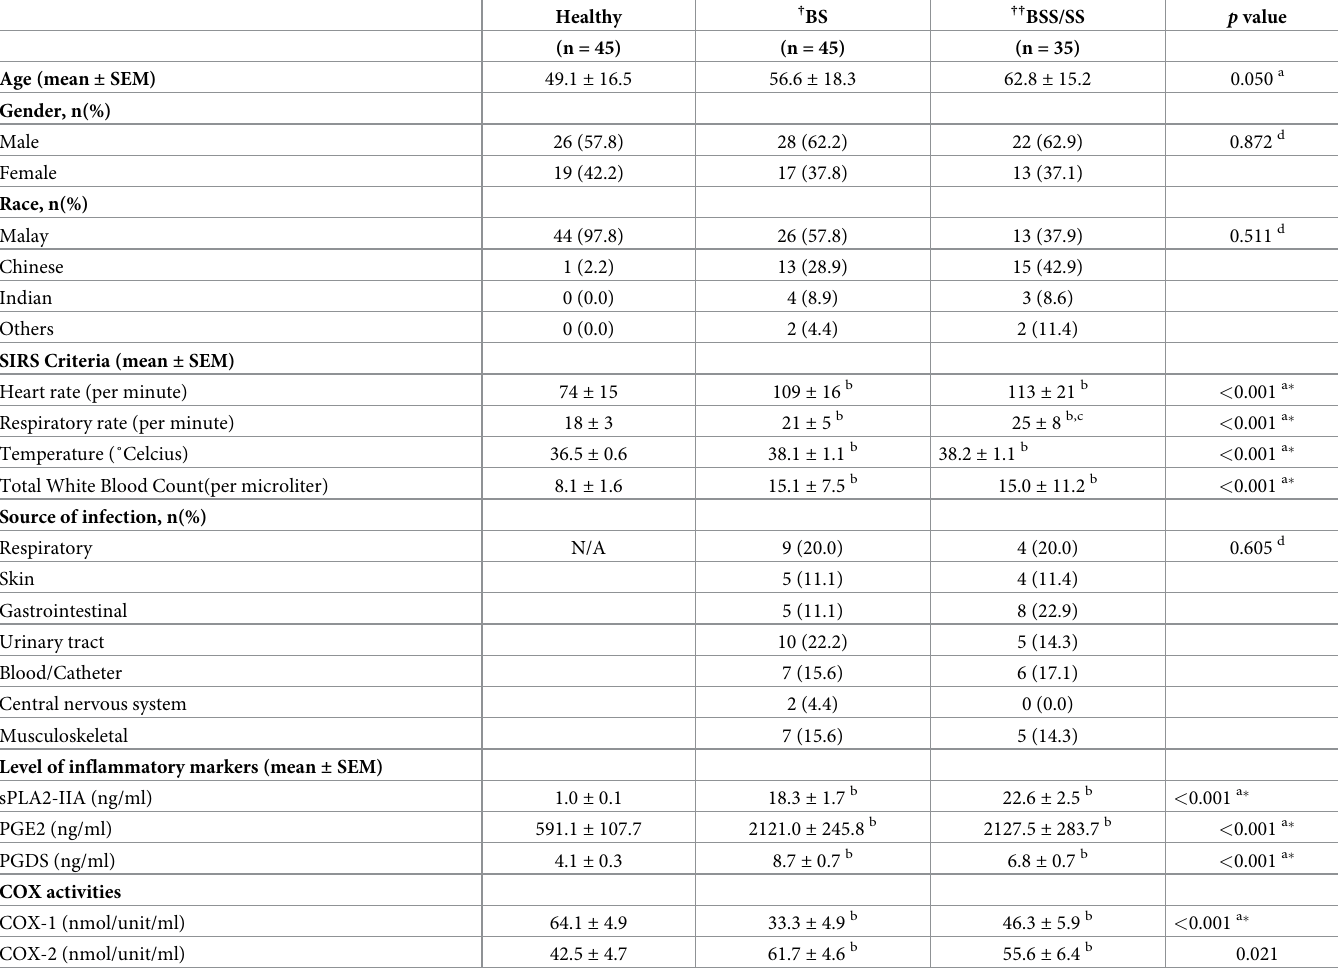
Table 1. Demographic and clinical characteristics of healthy subjects, bacterial sepsis (BS) and bacterial severe sepsis/ septic shock